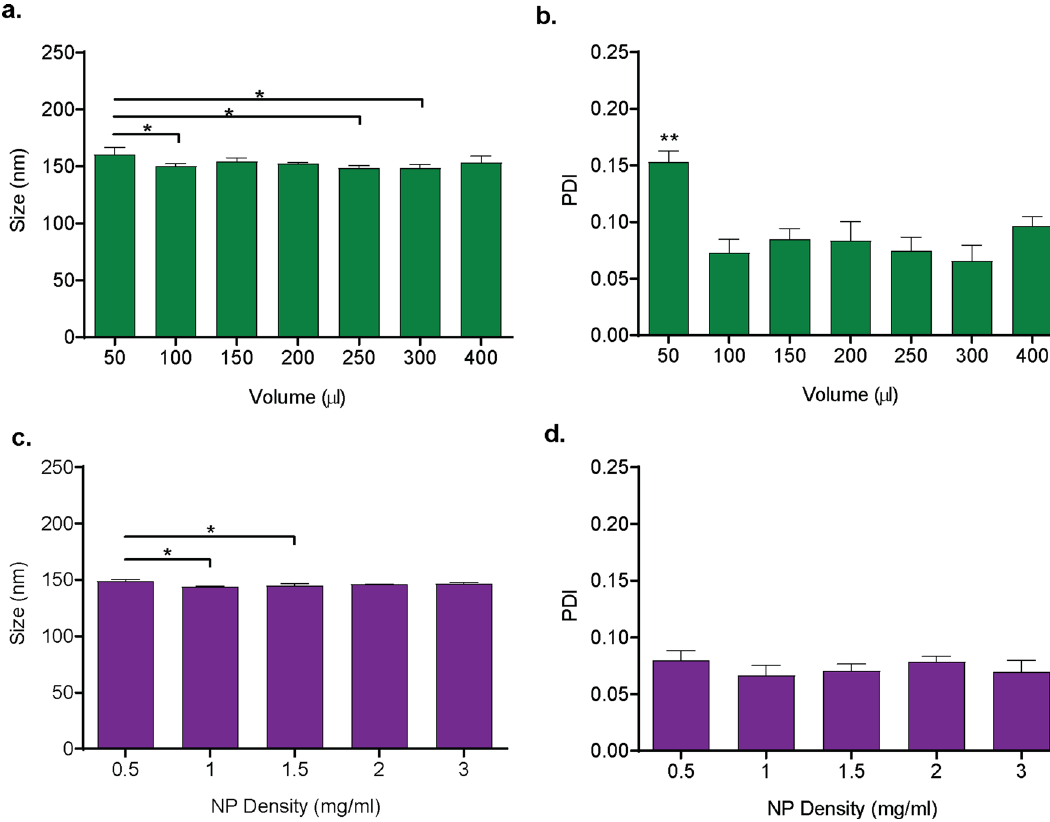
Figure 5. Effects of density and volume of the co-suspension on the efficiency of NP coating. PLGA nanoparticle (NP) and membrane vesicle co-suspensions at a ratio of 1.0 mg NP to 0.15 mg total membrane protein were sonicated (5 min., 15 °C, 60%) to induce coating and then incubated at room temperature under constant agitation for 4 days. ( a ) Size (nm) and ( b ) polydispersity index (PDI) of co-suspensions that were sonicated at different total volumes and a constant density of 1.0 mg/ml NPs. ( c ) Size (nm) and ( d ) PDI of co-suspensions that were sonicated at different NP densities, with a fixed volume of 150 µl. Data shown are all the mean ± SD, n = 3–4. * p < 0.05 as indicated, ** p < 0.05 vs. all other volumes, 1-way ANOVA with Tukey’s post hoc test.